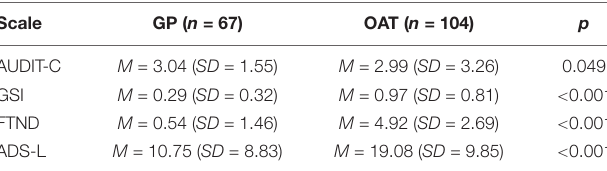
TABLE 3 | Descriptive statistics and differences in total scale scores as determined by Mann-Whitney-U